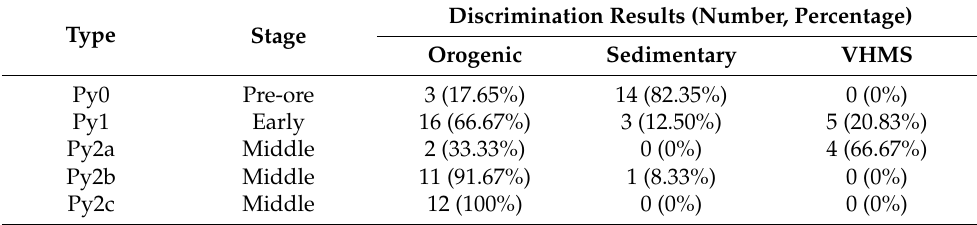
Table 4. Classification results for different types of pyrite from the Dunbasitao gold deposit based on the study by Zhong et al.